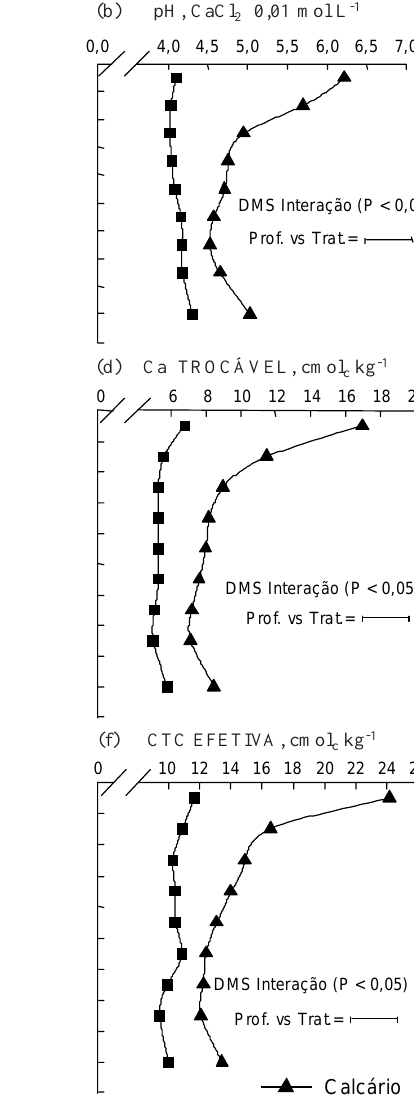
Figura 5. Valores de pH em água (a), pH CaCl 0,01 mol L -1 (b), alumínio trocável (c), cálcio trocável (d), 2 magnésio trocável (e) e CTC efetiva (Ca 2+ + Mg 2+ + K + + Al 3+ ) (f) do solo quatro semanas após a aplicação ou não do calcário